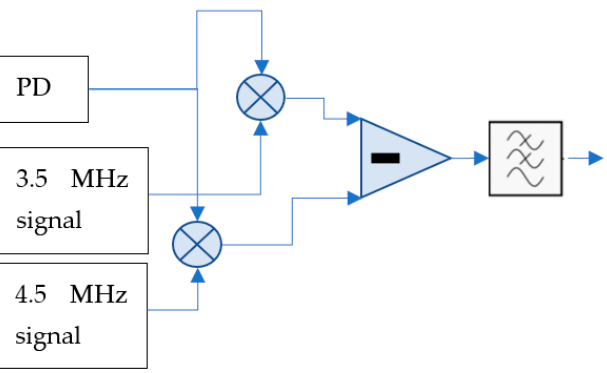
Figure 8. Demodulation algorithm implementation with analog mixers, differential stage and low- pass filtering. PD, photodetector at the output of Figure 4.